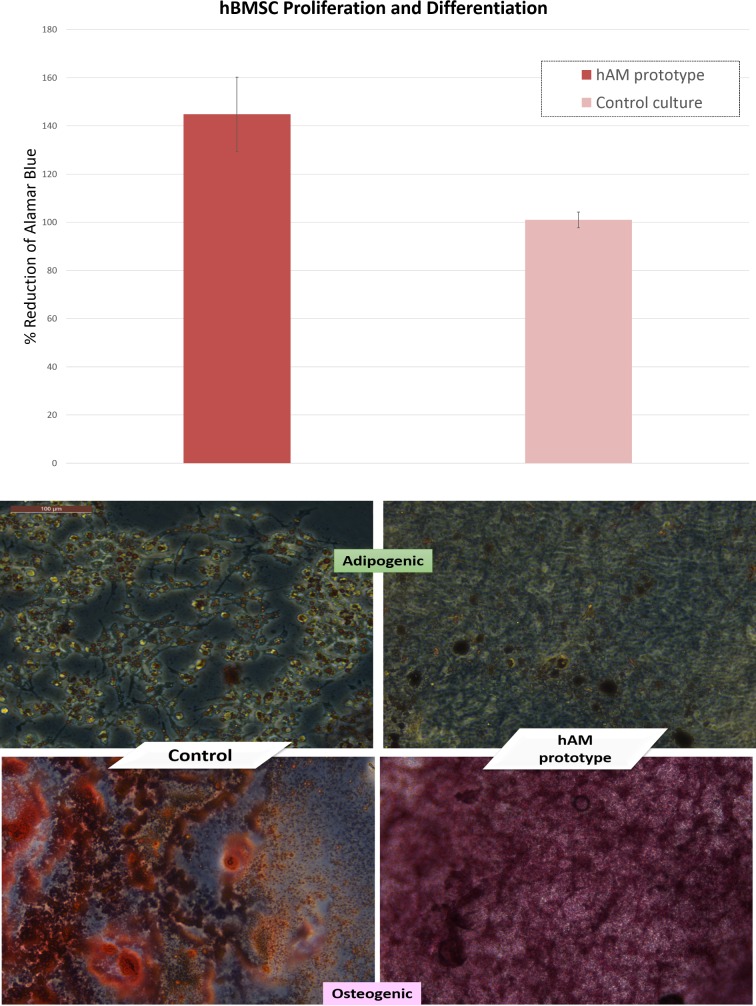
Proliferation and Differentiation of Human Bone Marrow Stem Cells (hBMSC) in the Biomimetic Platform.The top panel shows a graph depicting proliferation of the hBMSCs as expressed by the relative % reduction of the Alamar Blue reagent using the absorbance values in the study group compared to the control group. The lower panel presents inverted microscope images (x10) of adipogenic (top) and osteogenic differentiation (bottom) of hBMSC grown on prototype 1(hAM coated plates) and control culture plate.